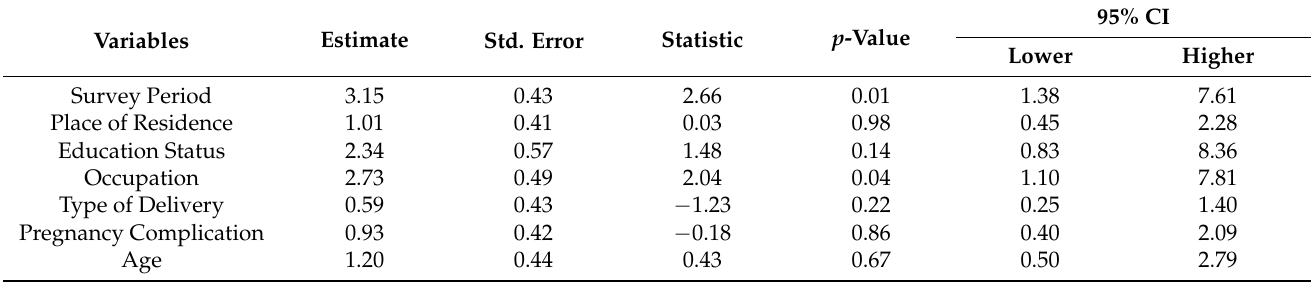
Table 3. Univariate logistic regression for the association between participants’ characteristics, childbirth period, and postpartum depression (EPDS score ≥ 13) during the COVID-19